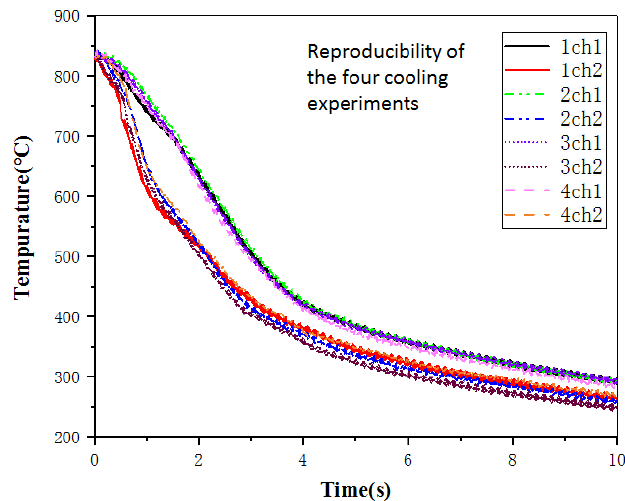
Figure 5. Measurement results of the cooling curves.